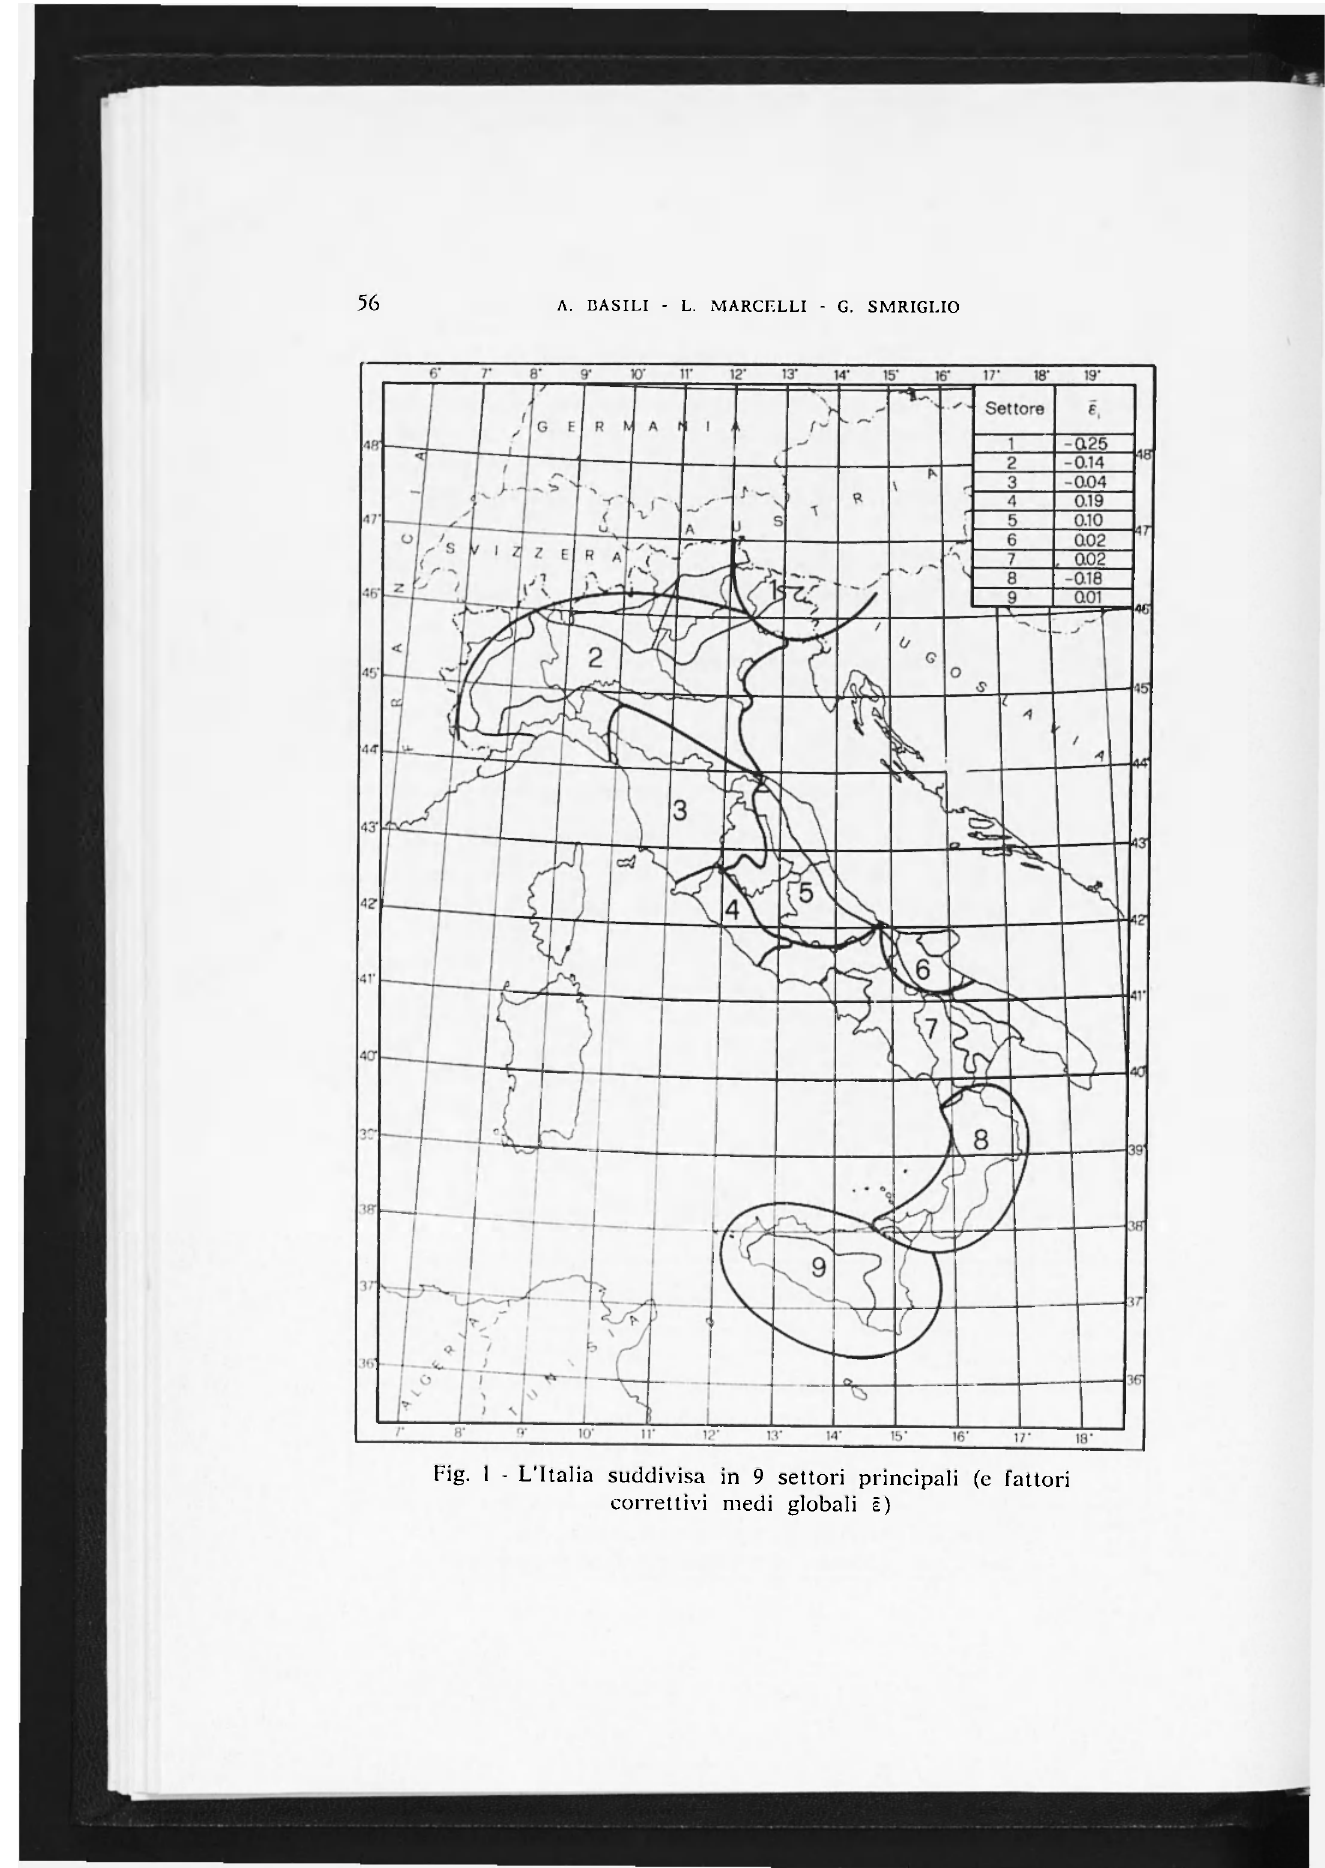
Fig. 1 - L'Italia suddivisa in 9 settori principali (e fattori correttivi medi globali